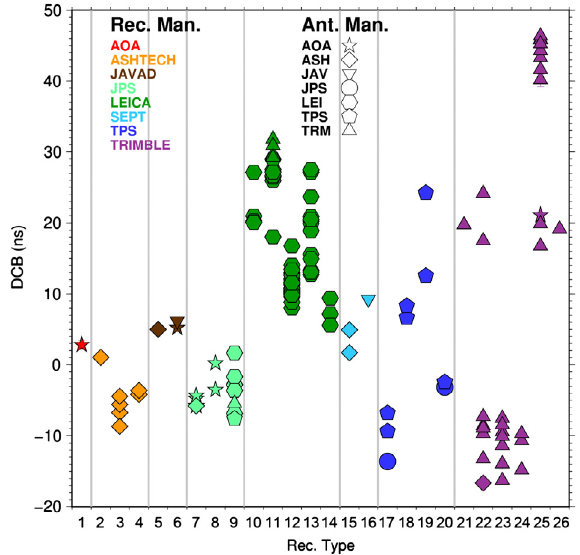
Fig. 1. Mean values of P1-P2 DCBs estimated for 117 stations of the EPN for the period 2012 to mid-2013. Each colour corresponds to a receiver manufacturer. The different receiver types produced by a given manufacturer (Rec. Type) are also taken into consideration (see Table 1). Each symbol corresponds to a specific antenna